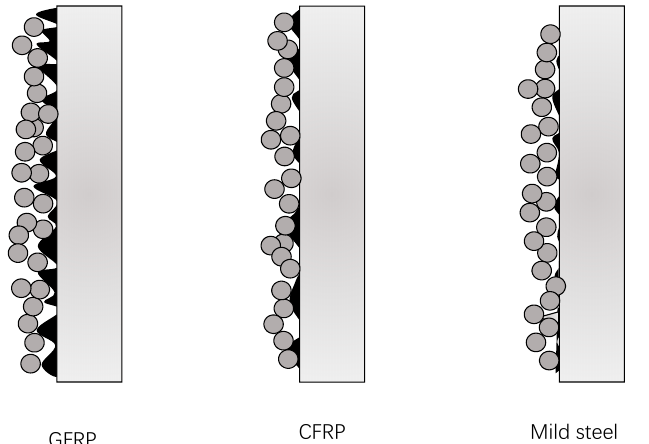
Figure 14. Illustration of the interfacial resistance between soil particles and the surface of the FRP piles.